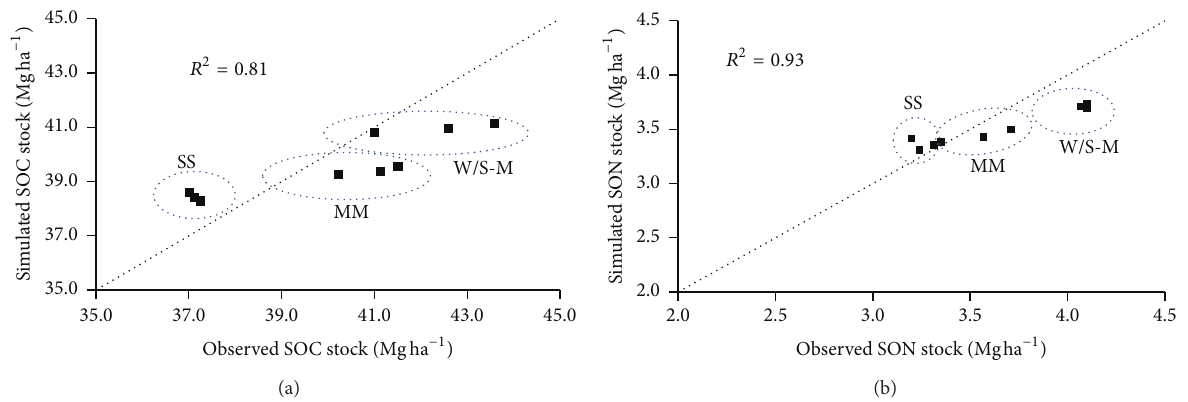
Figure 9: Comparison of observed and simulated SOC (a) and SON (b) in NT period. SS: soybean monoculture; MM: maize monoculture; W/S-M: doubled-cropped wheat/soybean